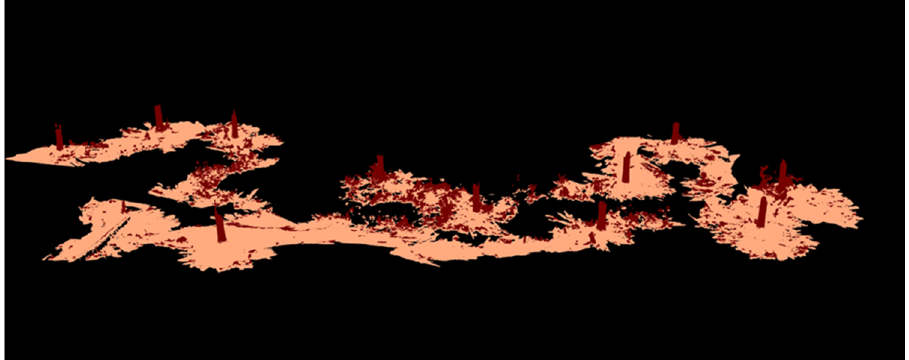
Figure 11. iPad LiDAR data divided into terrain cloud (cream color) and vegetation cloud (brown). To measure the DBH values of the trees in the vegetation point cloud, each tree was divided into a file with a single tree for measurement. All points that did not belong to the target tree in the point cloud could be manually deleted (Figure 12).